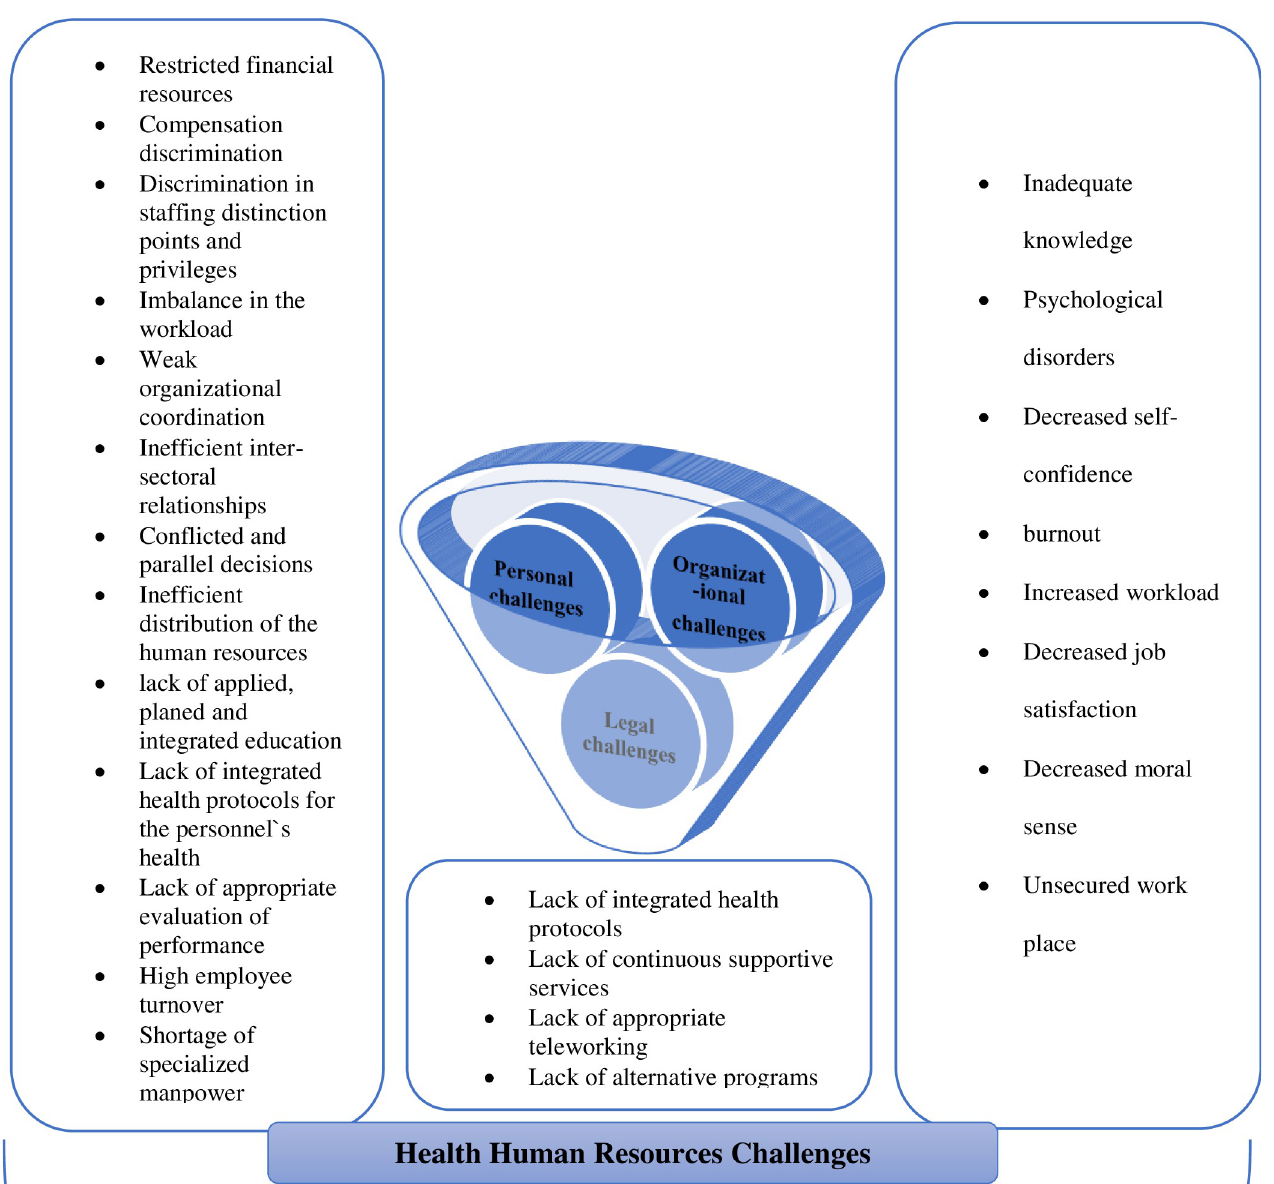
Fig 1. The schematic network of Iranian health human resources challenges during